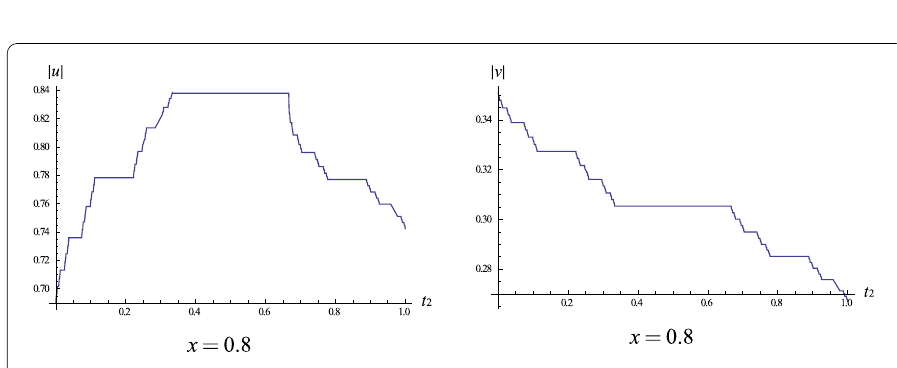
Figure 2 Profiles along the t 2 axis of one-fractal solutions (78) with α =